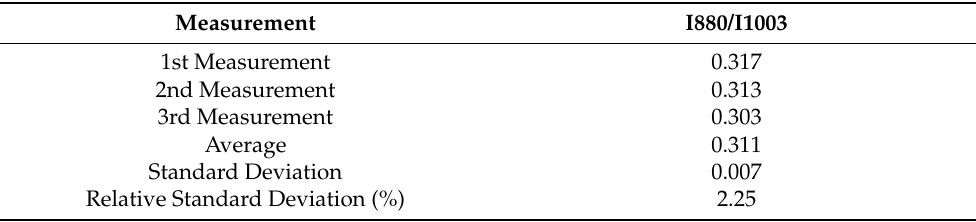
Table 5. Repeatability of the method of gold-coated slide with cavity for a urine sample spiked with 5 µ L/mL